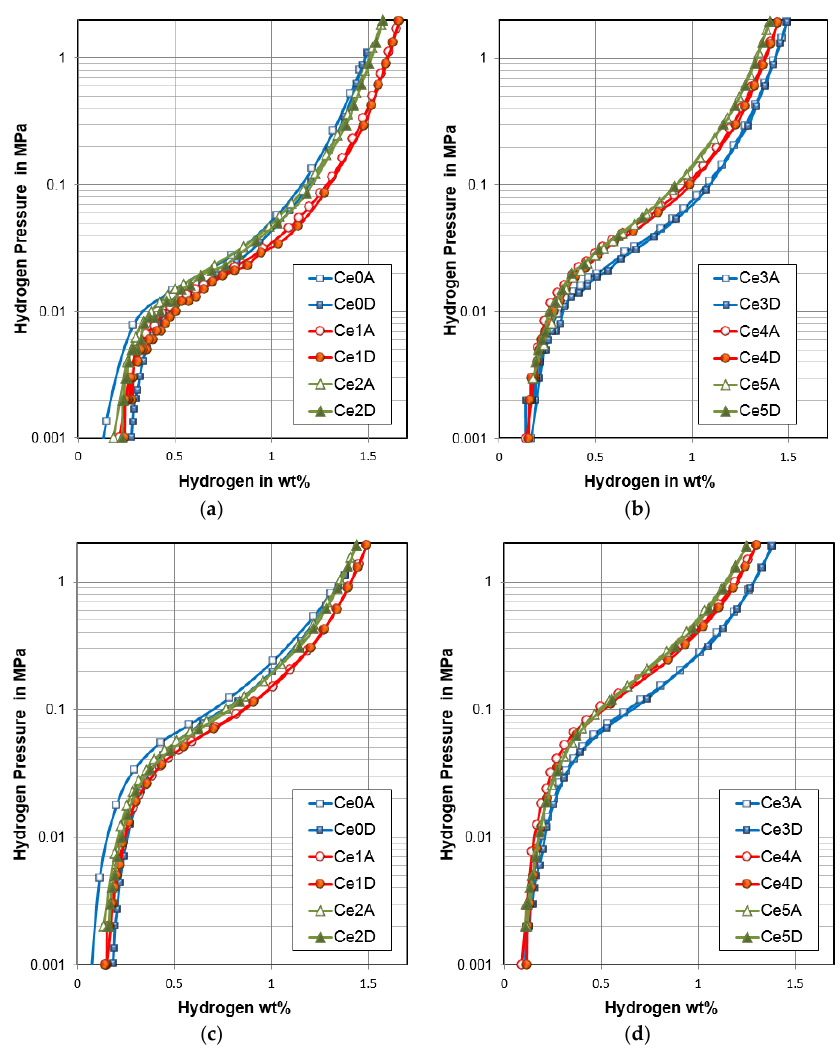
Figure 6. Pressure–concentration–temperature (PCT) isotherms measured at 30 °C for ( a ) alloys Ce0, Ce1, and Ce2; and ( b ) alloys Ce3, Ce4, and Ce5; and at 60 °C for ( c ) alloys Ce0, Ce1, and Ce2; and ( d ) alloys Ce3, Ce4, and Ce5. Table 5. Summary of gaseous phase properties, including the maximum and reversible capacities, desorption pressure at 0.75 wt% H-storage capacity, slope factor ( SF ), hysteresis, and changes in enthalpy and entropy.